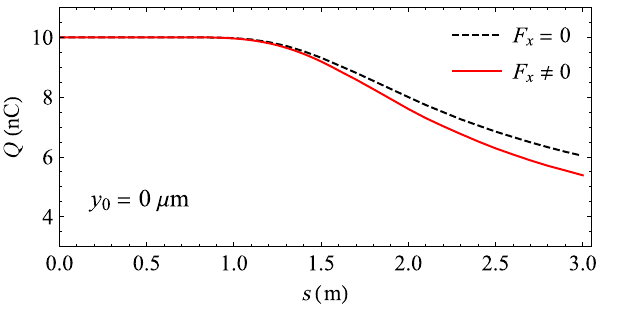
FIG. 13. Bunch charge as a function of propagation distance through the structure with the beam offset vertically by y ¼ 50 μ m. Plots are shown for F 0 x removed (dotted line) and included (solid line).